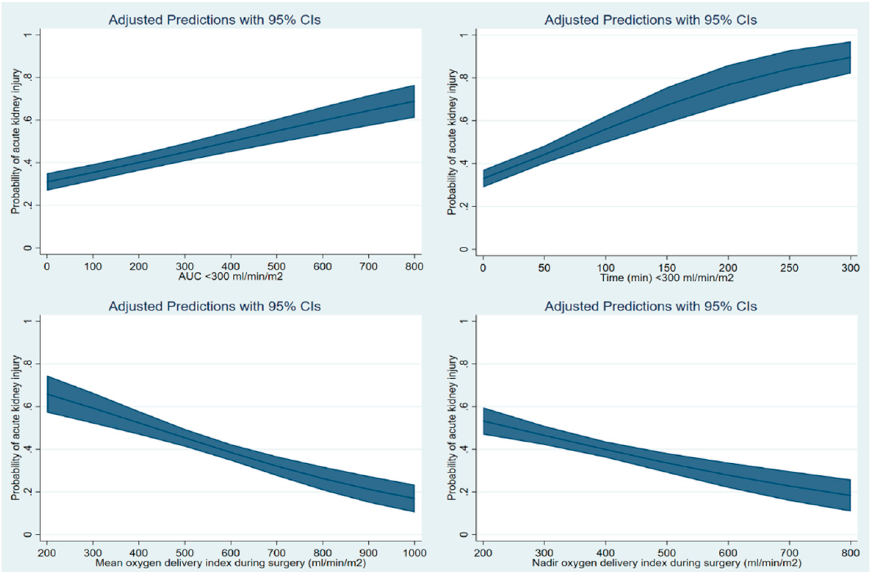
Figure 2. The cubic spline function curves of the multivariable-adjusted relationship between the area under the threshold of oxygen delivery index (DO 2 I) of 300 mL/min/m 2 (AUC < 300) (upper left) or the cumulative time below the threshold of DO 2 I of 300 mL/min/m 2 (time < 300) (upper right) or mean DO 2 I during surgery (lower left), or nadir DO 2 I during surgery (lower right) as continuous variables and the risk of acute kidney injury after liver transplantation.